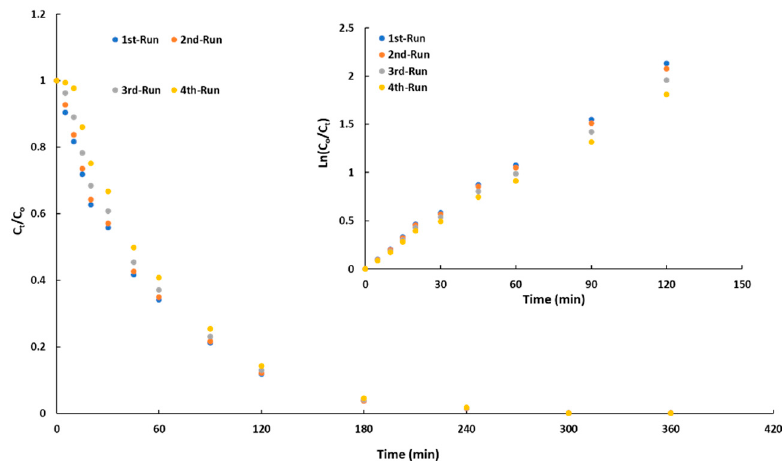
Figure 9. Kinetics of BB41 photodegradation at different photocatalytic consecutive runs. The figure inset contains the linear regression of the kinetic data. Table 6. Summary of the kinetics results obtained for the consecutive catalytic photodegradations of BB41 using C / ZnO / Zn and values obtained for the leaching of Zn during after the catalytic runs. k app × 10 − 3 Photocatalytic Run